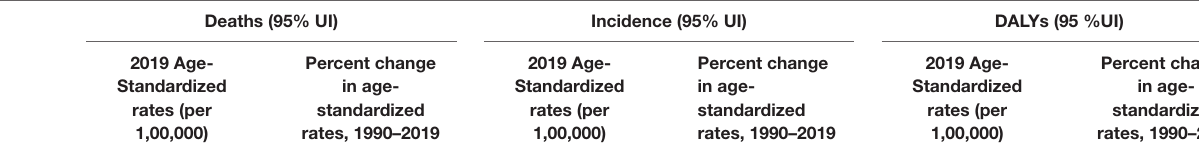
TABLE 2 | Percent change in age-standardized rates of childhood asthma by age group, sex and SDI, 1990–2019.